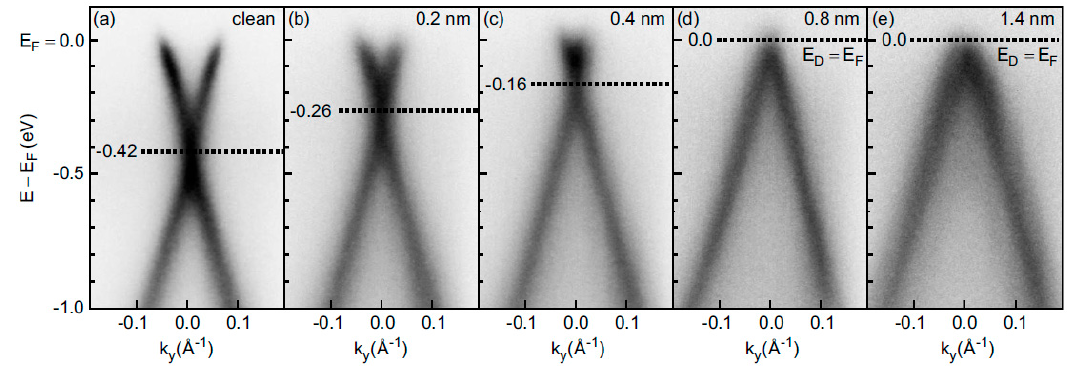
Figure 19. ARPES measured π bands for around K point for the Brillouin zone for ( a ) as-grown graphene monolayer on SiC (0001) ( b – e ) increasing amount of F4-TCNQ. Reprinted with permission from Reference [79].